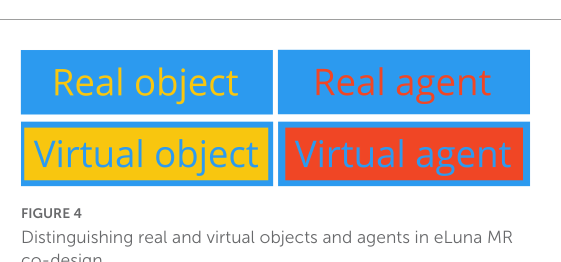
FIGURE4 Distinguishing real and virtual objects and agents in eLuna MR co-design.